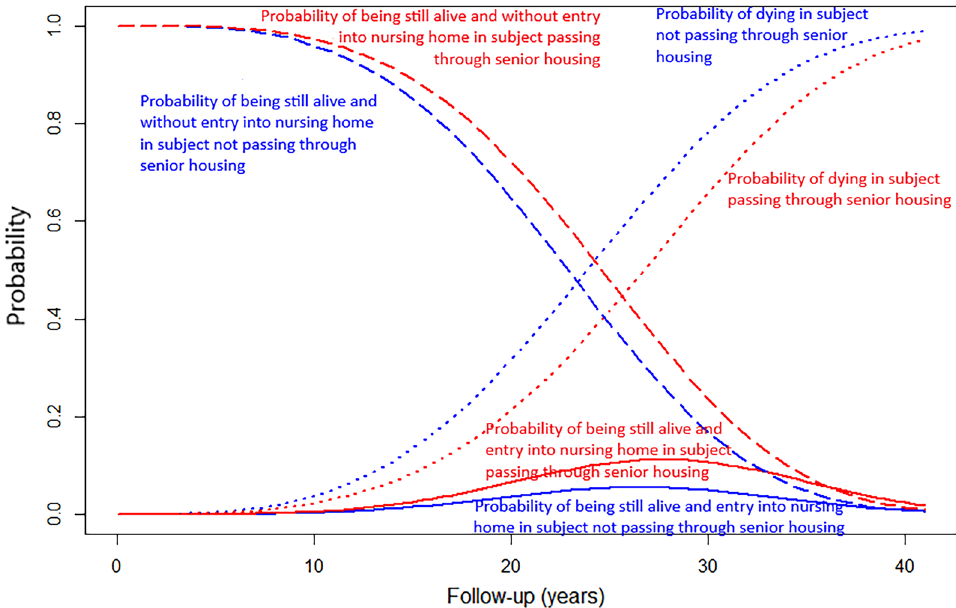
Figure 1. Estimated probabilities of death, nursing home admission, and being alive according to residential status (no senior housing in blue versus senior housing in red).